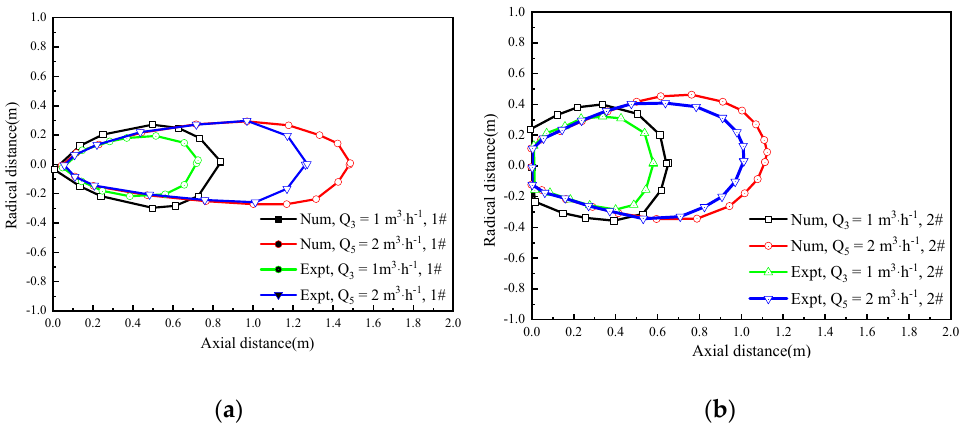
Figure 5. Comparing model results with experimental results in the oxygen-enriched area under un-air-conditioned conditions. ( a ) 1#, ( b ) 2#.